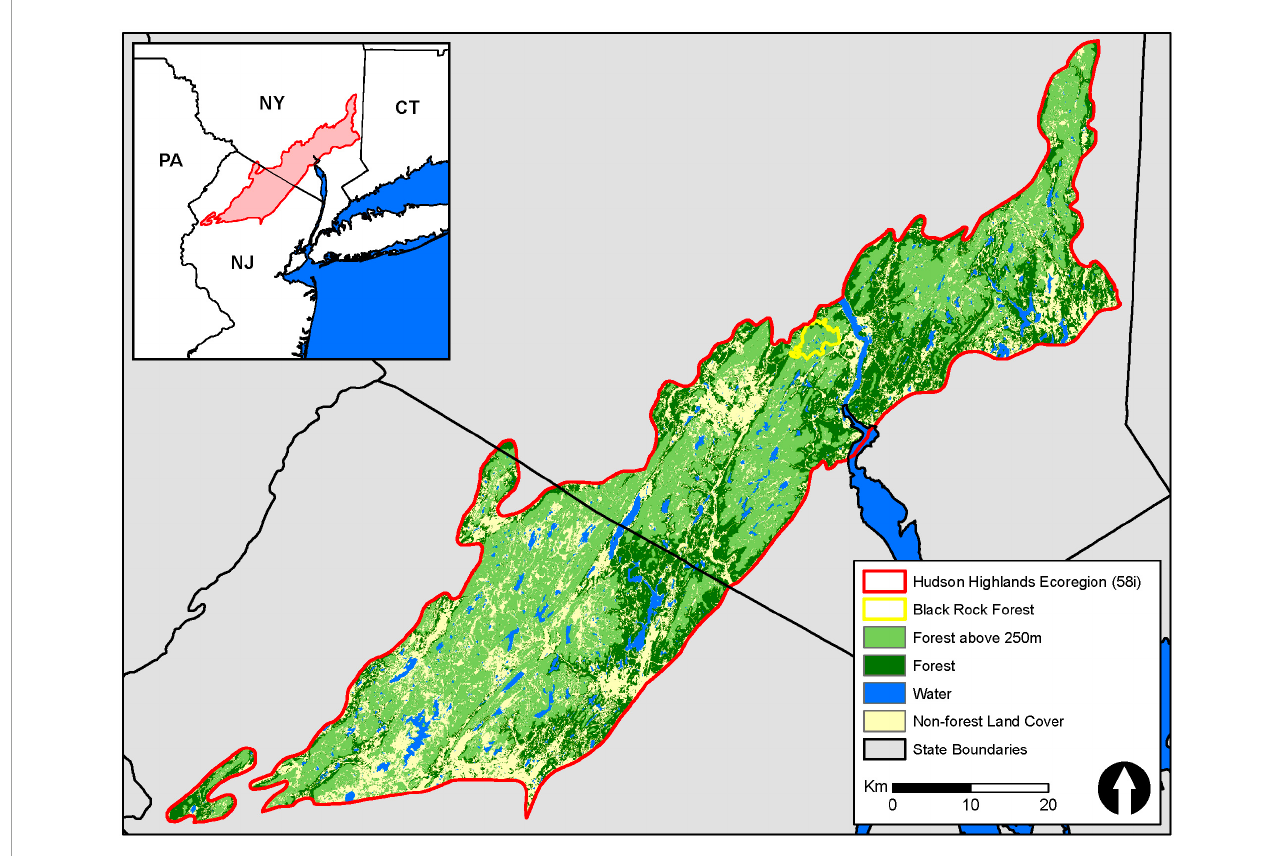
FIGURE1 Extent of the Hudson Highlands Ecoregion (red outline) in southern New York and northern New Jersey. Greens indicate the extent of forest cover within the Ecoregion and light green indicates the extent of forest area that was likely impacted by the defoliating spring frost event on May 8, 2020. Land cover type was derived from the 2019 National Land Cover Database. Extent of defoliation was estimated using differences in NDVI between 2019 and 2020 to determine elevation